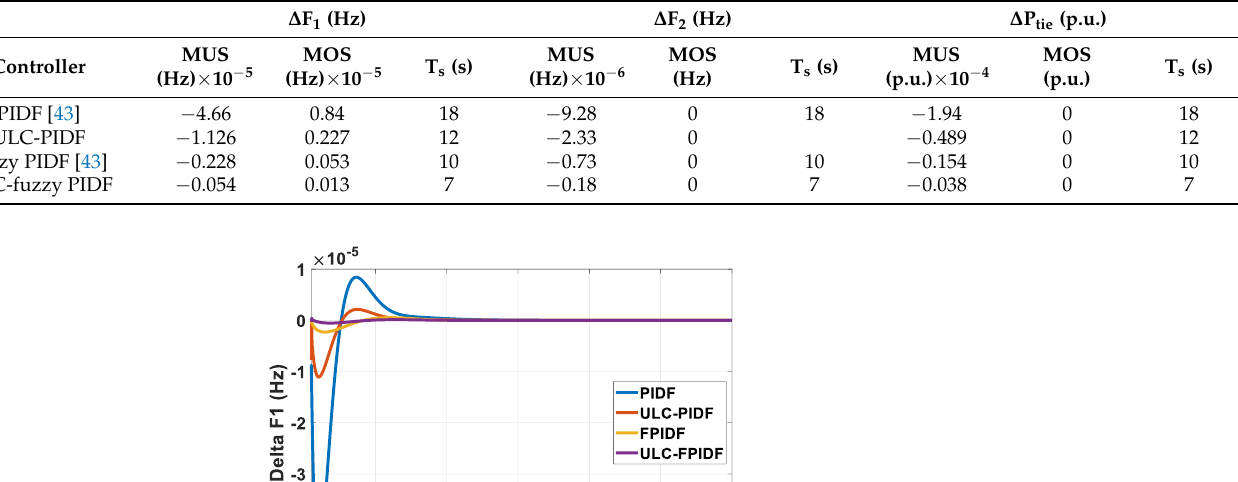
Figure 9. Convergence curves of the MPA algorithm for ( a ) ULC-PIDF and ( b ) ULC-fuzzy PIDF controllers. Table 3. optimal performance and gains of various controllers in terms of fitness.